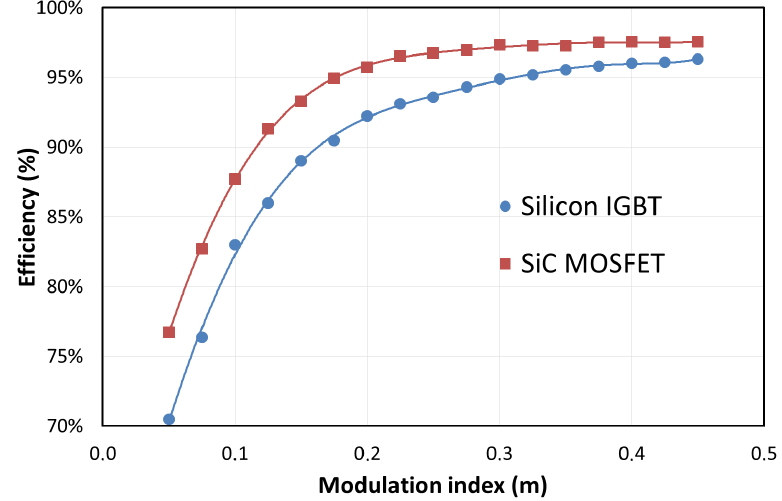
Figure 16. Efficiency comparison with different semiconductors: H8 CCMV SVM architecture